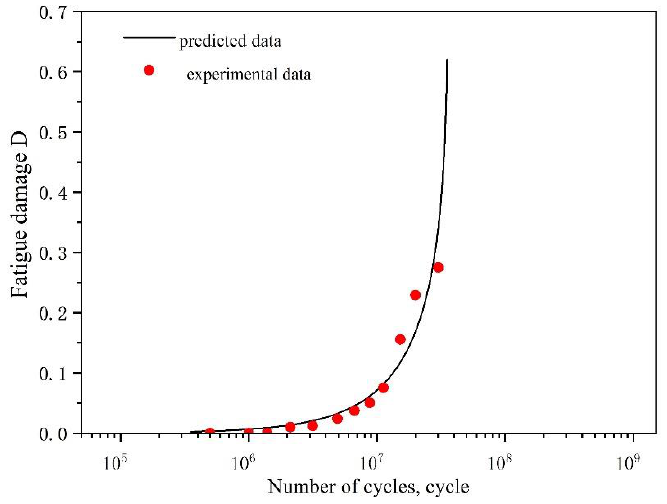
Figure 7. Comparison of the prediction of fatigue damage and experimental data at 450 MPa stress amplitude.